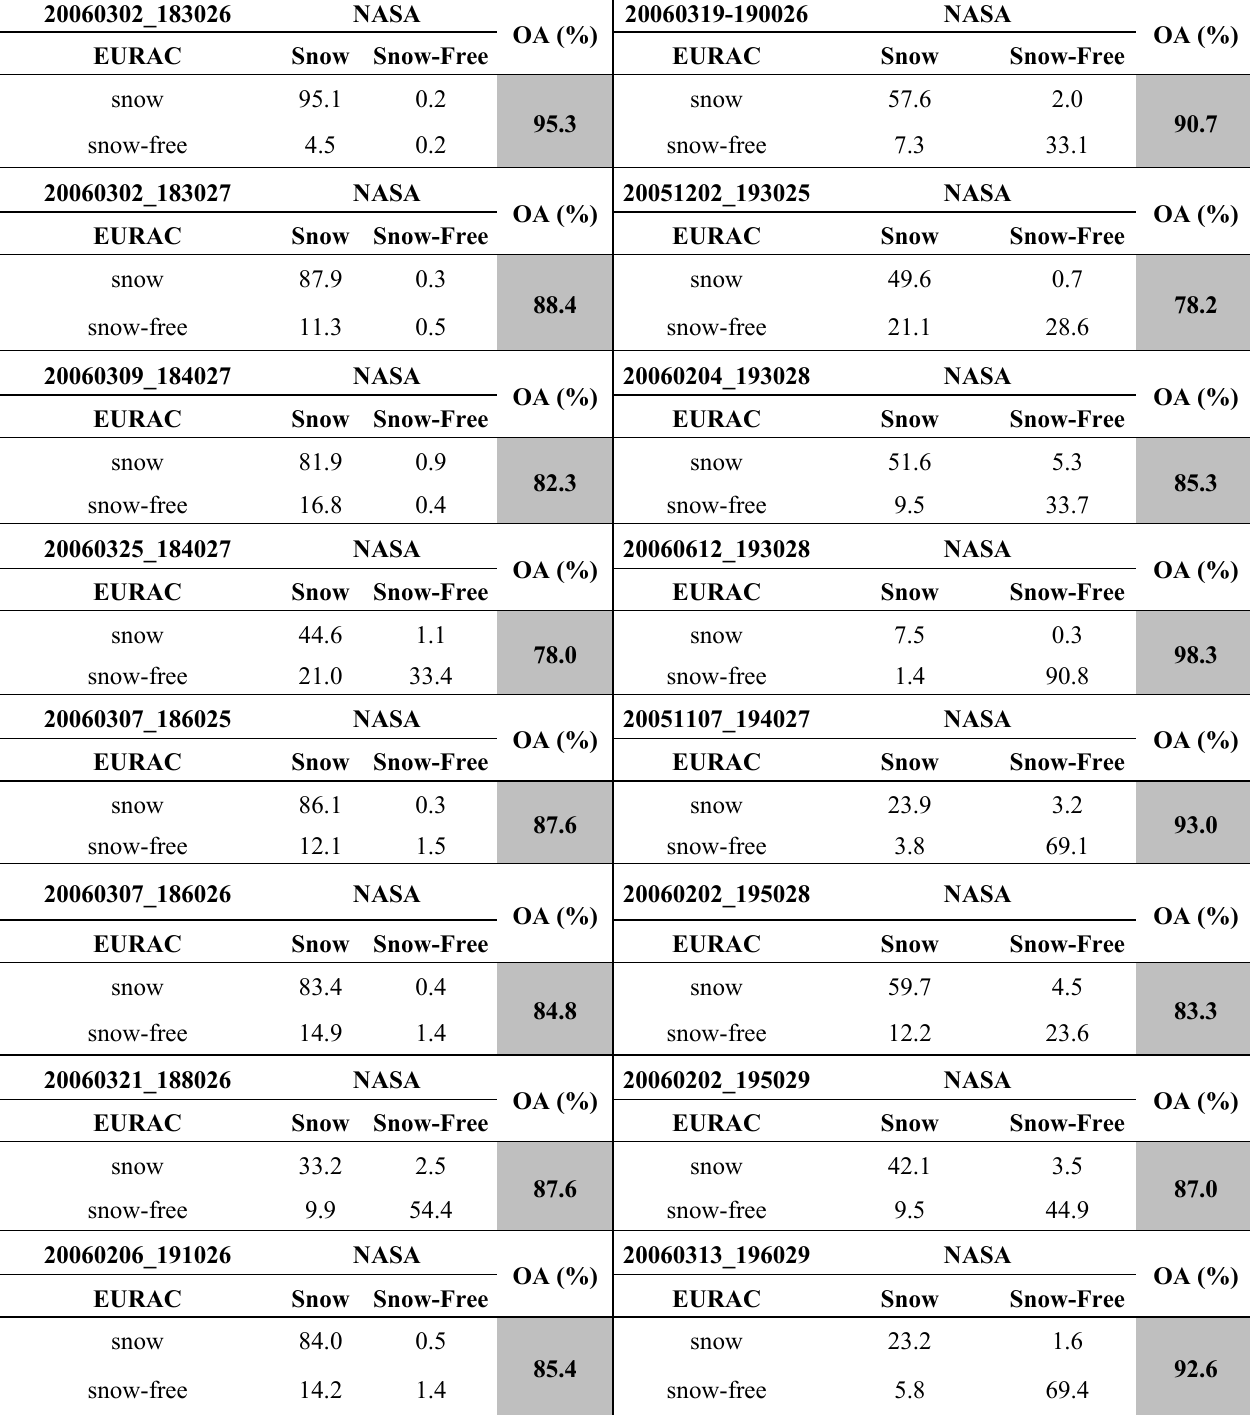
Table 3. Confusion matrix of the EURAC snow cover maps (SCA) maps and NASASCA maps for the period of August 2005 to July